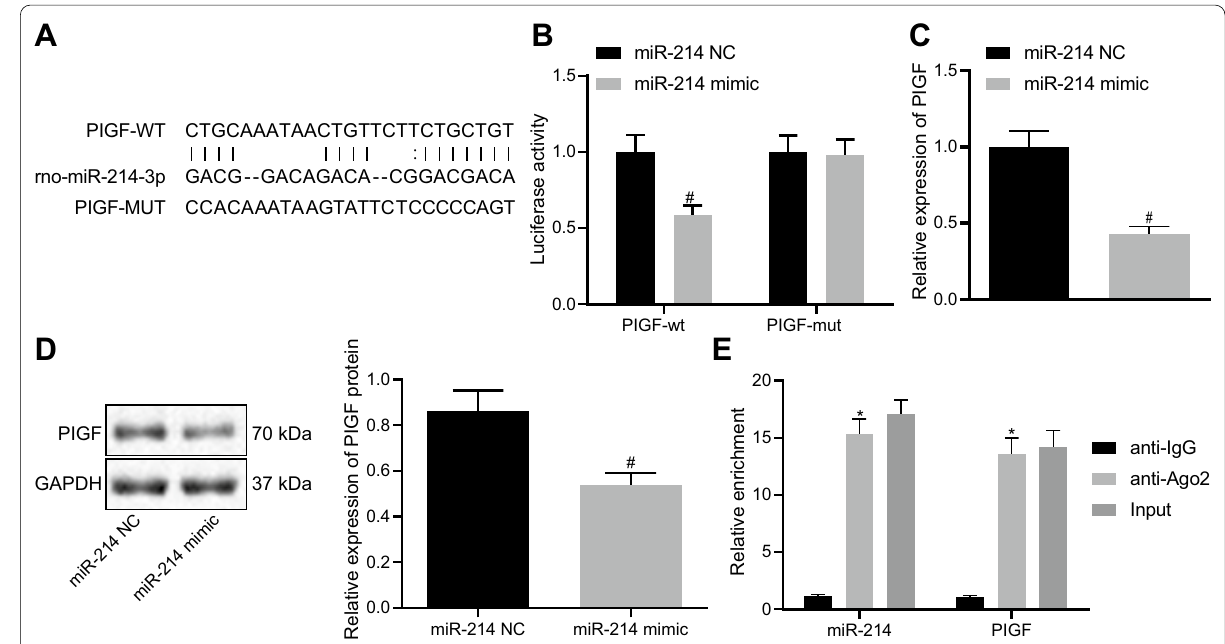
Fig. 5 PlGF is identified as a target of miR‑214. A The predicted binding sites of miR‑214 and PlGF. B Dual luciferase reporter assay analysis of the binding of miR‑214 to PlGF. C RT‑qPCR determination of the mRNA level of PlGF following miR‑214 overexpression in cells. D Western blot analysis of PlGF following miR‑214 overexpression in cells. E RIP detection of the binding percentage of miR‑214 and PlGF to Ago2, normalized to IgG binding. Data are summarized as mean standard deviation. * p < 0.05 vs. anti‑IgG. # p < 0.05 vs. cells transfected with miR‑214 NC. An independent ± sample t ‑test was used for comparisons between two groups. Multiple group comparisons were performed using one‑way ANOVA, followed by Tukey’s post hoc test. Each experiment was repeated three